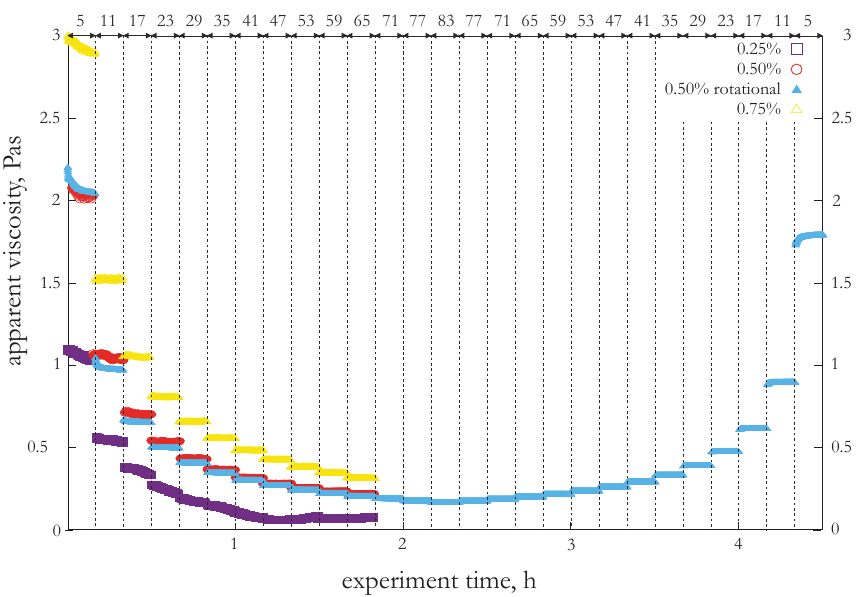
Figure 5. Apparent viscosity change for different xanthan concentration across shear rate range from 5 s − 1 to 65 s − 1